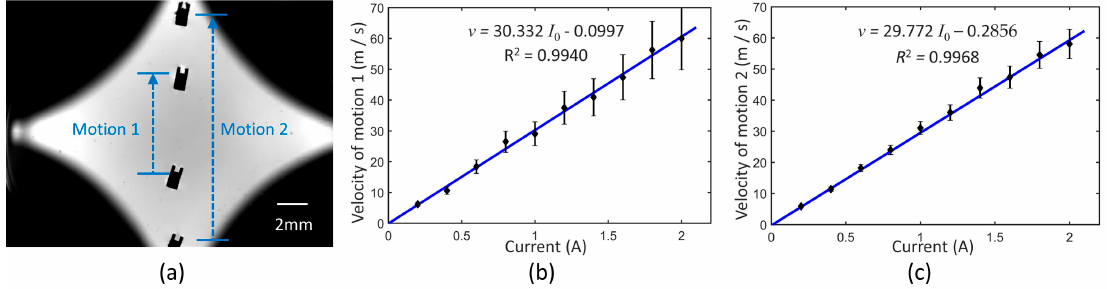
Figure 8. ( a ) Schematic of velocity measurement. ( b ) Average velocity of motion 1 actuated by coils. ( c ) Average velocity of motion 2 actuated by coils.